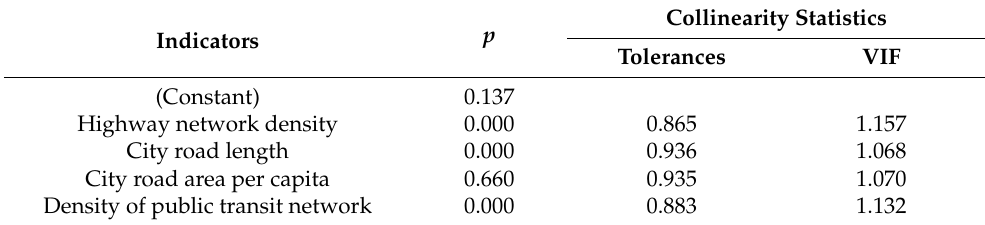
Table 2. Diagnostic analysis of indicators.